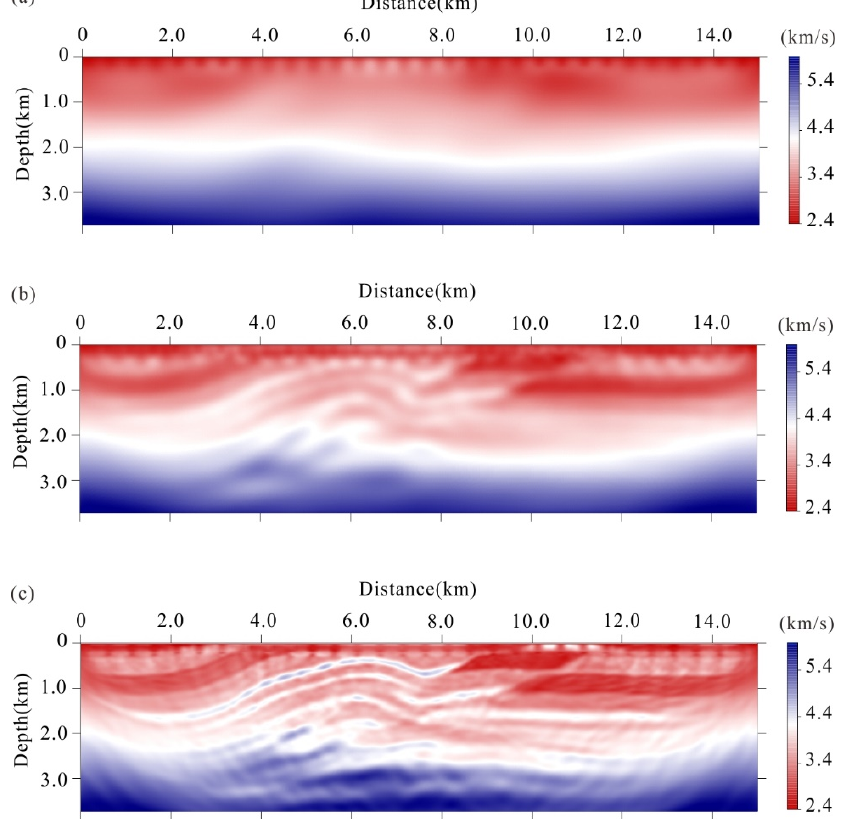
Figure 5. Schematic showing the waveform inversion results of the overthrust velocity model. ( a – c ) represent the inversion results at three frequency bands: [0.5–1.6], [1.5–4.9], and [4.8–16.3].